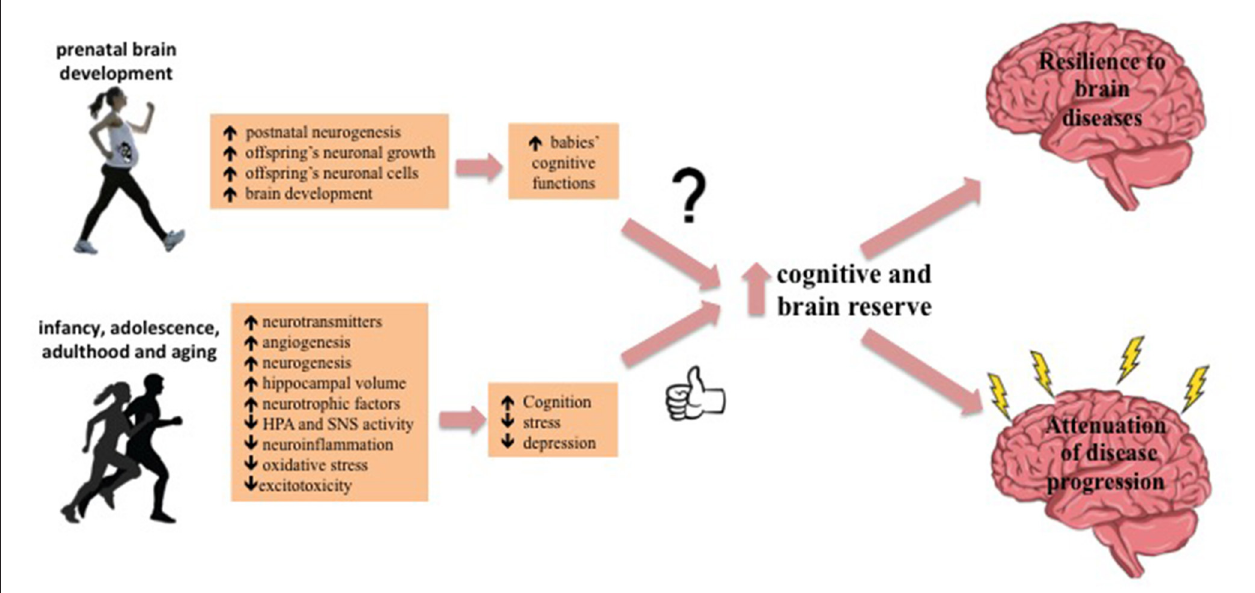
FIGURE 2 | Model of how exercise can confers brain resilience. Exercise positively influences brain and cognitive reserve by multiple pathways, protecting against the consequences of stressful events, improving health, and reduce the risk of chronic